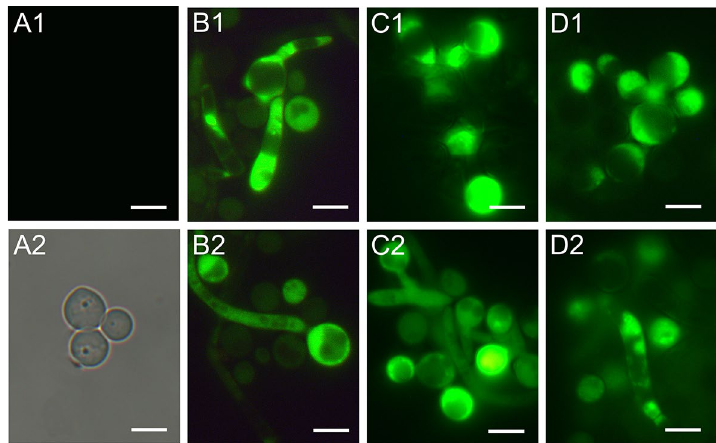
Figure 3. Detection of oxygen-reactive species in C . albicans cells from the: ( A1 , A2 ) control culture; A2 shows a bright field image of A1, and the AAF-treated cultures: ( B1 , B2 ) at the concentration of 25 µg mL −1 , ( C1 , C2 ) 50 µg mL −1 , and ( D1 , D2 ) 100 µg mL −1 . The cultures were treated with AAF for 48 h. Fluorescence images were obtained after staining with 2 ′ ,7 ′ -dichlorofluorescin diacetate (H 2 DCF-DA). Bars represent 5